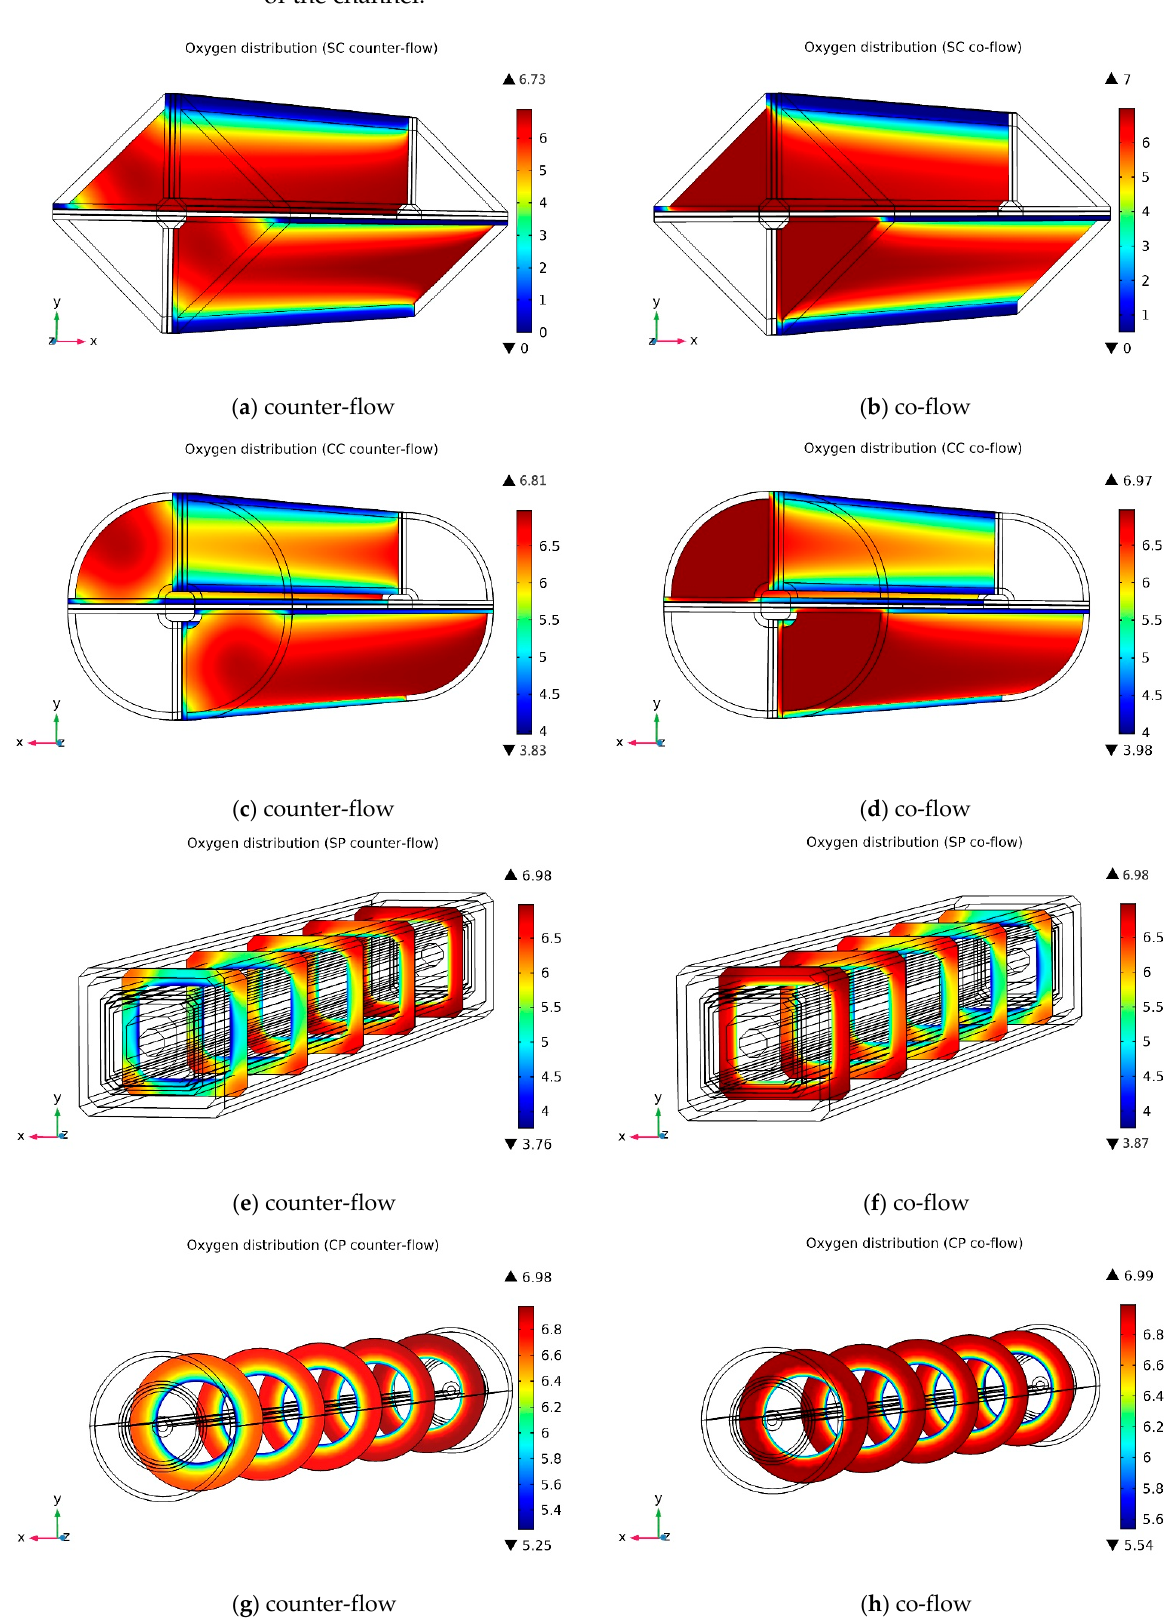
Figure 5. Molar concentration distribution diagram of oxygen(mol/m 3 ) at V = 0.4